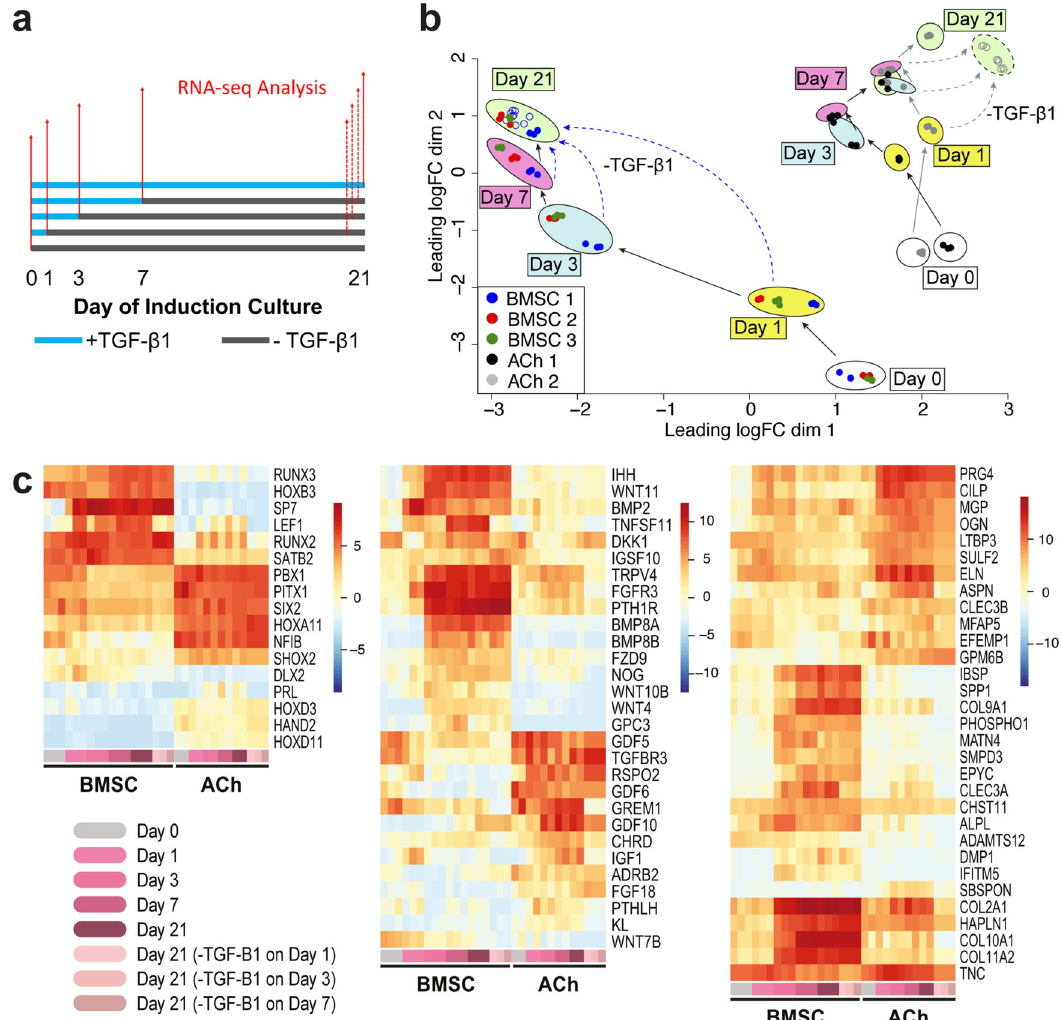
Fig. 6 RNA-sequencing analysis. a Whole transcriptome analysis was performed for BMSC and ACh cultures treated with TGF- β 1 (blue lines) and harvested on days 0, 1, 3, 7, and 21 as indicated by the solid red arrows (BMSC donors 1, 2, and 3, and ACh donor 1 and 2). Additionally, for BMSC donor 1 and ACh donor 2, RNA-seq analysis was performed on day 21 following TGF- β 1 withdrawal on days 1, 3, and 7, represented by dashed red arrows. b MDS plot reveals the convergence of BMSC cultures on a common gene expression pro fi le by day 21. This gene expression pro fi le was common in 21-day cultures, despite being exposed to exogenous TGF- β 1 for different durations (1, 3, 7, or 21 days). BMSC and ACh gene expression was dissimilar in samples treated in the same way. Solid arrows in the MDS plot show the progression of gene expression pro fi les from day 0 cultures maintained continuously in TGF- β 1, and analyzed on day 1, 3, 7, or 21. Dashed arrows point to the changes in global gene expression on day 21, following TGF- β 1 withdrawal from cultures on day 1, 3, or 7. c Differentially expressed genes related to osteochondral transcription factors (left), soluble factors and receptor signaling (middle), and ECM molecules and ECM biosynthesis (right). Each timepoint in the heatmap is represented by a color shown on the bottom row of the heatmap, which corresponds to the color key on the bottom left of the fi gure. Each BMSC timepoint has three columns, representing three unique BMSC donors, and each ACh timepoint has two columns, representing two unique ACh donors; only one BMSC donor and one ACh donor was sequenced on day 21 with TGF- β 1 withdrawal on day 1, 3, or 7, and are represented by the lighter pink shades; heatmap colors represent the average of normalized logCPM values from three culture